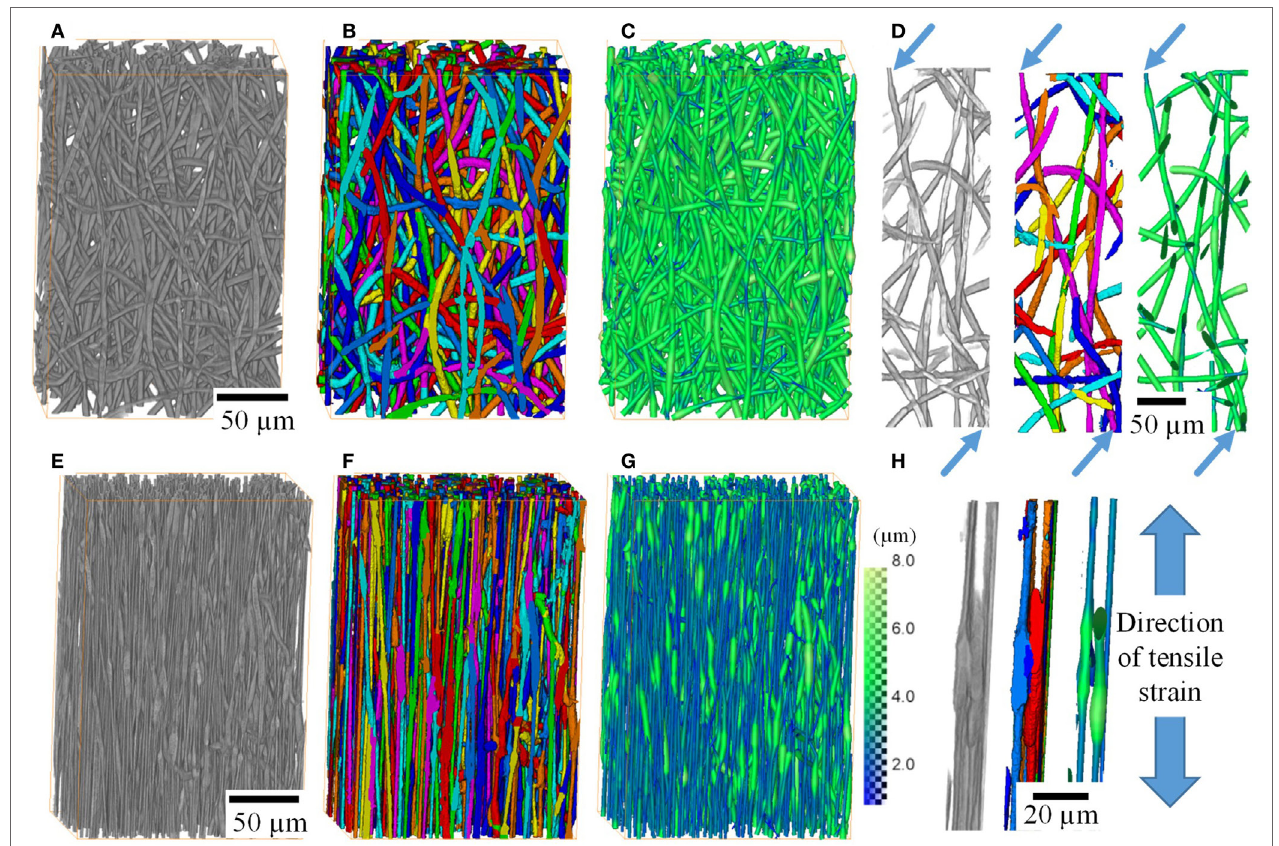
FigUre 3 | 3D rendering of small volumes of the P(3HB-co-4HB) fiber mats before any deformation (a––h) after application of 352% strain. Images show 3D volume rendering after filtering (a,e) , segmentation of individual fibers (B,F) and with fiber thickness displayed as color intensity (c,g) . Fibers can be traced and segmented accurately, enabling identification of individual fibers (D) and contact points between these (h) . Scans of the fiber mats were performed unstrained and after loading. Loaded samples were left to stabilize for 5 min at constant strain before scanning in their loaded